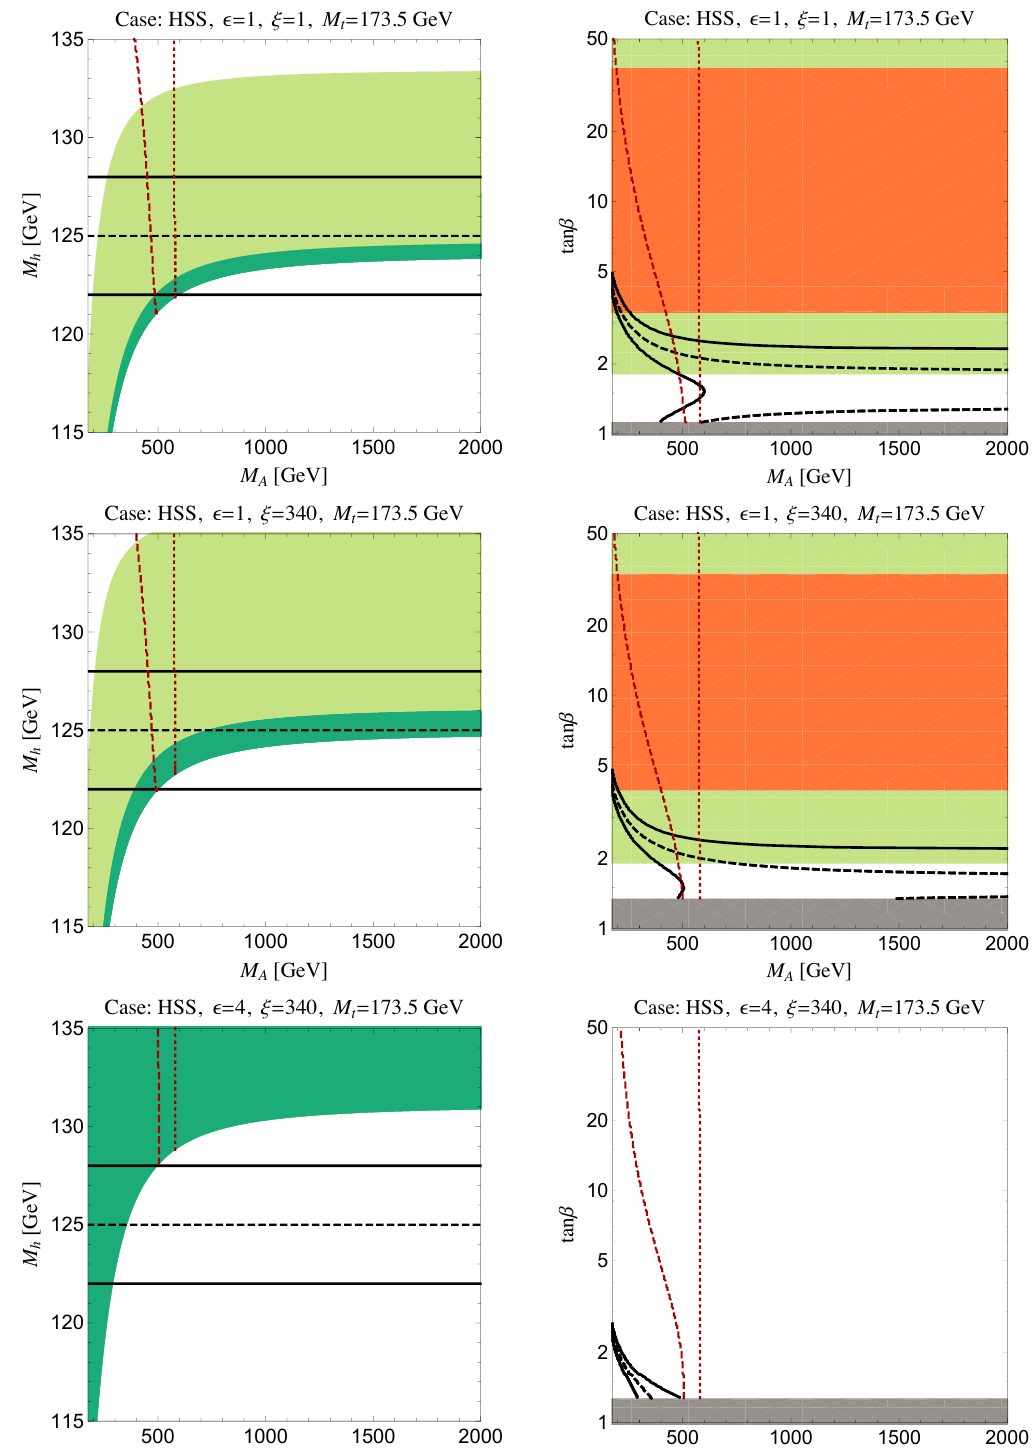
Figure 4 . The details are same as given in the caption of (cid:12)gure 1. For all the cases, N = 2 : 07.